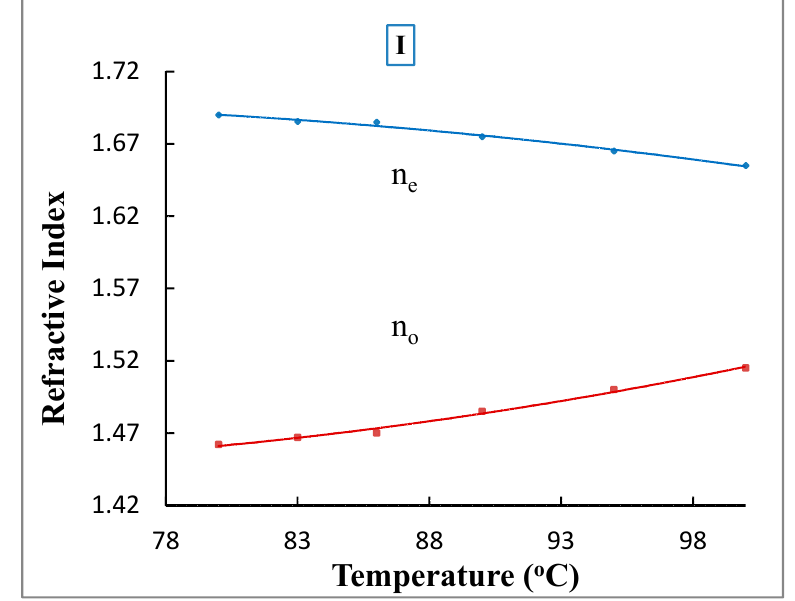
Figure 6. Dependence temperature of refractive indices ( ) n o and ( ) n e for compound I at 543 nm.